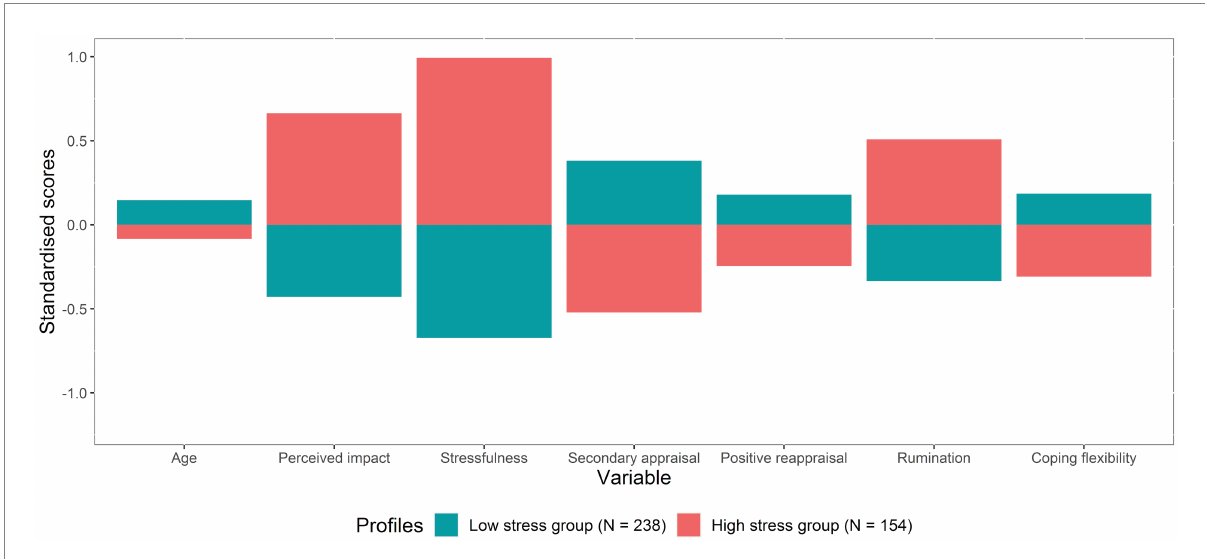
FIGURE 1 Visualization of the standardised scores of the included variables per profile of the 2-profile